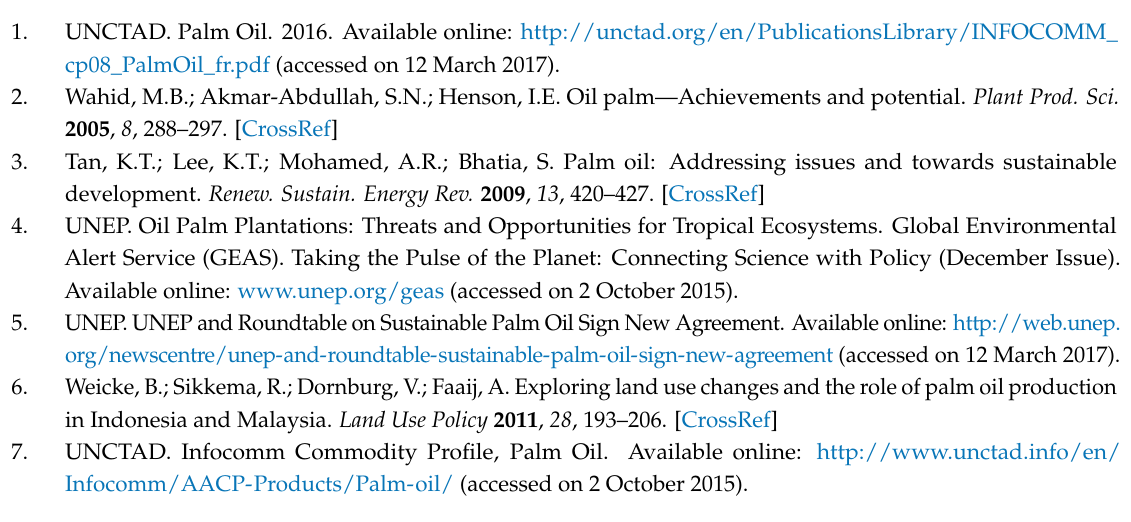
Figure S1: Default values for remaining SOC fraction after land use change from [17] and IPCC (Penman et al., 2003), Table S1: Change of SOC stock on conversion of primary forest land in subtropical and tropical (30 ◦ N–30 ◦ S) regions, Table S2: Change of SOC stock on conversion of secondary forest land in subtropical and tropical (30 ◦ N–30 ◦ S) regions, Table S3: Change of SOC stock on conversion of pasture and grassland in subtropical and tropical (30 ◦ N–30 ◦ S) regions, Table S4: Change of SOC stock on conversion of cropland in subtropical and tropical (30 ◦ N–30 ◦ S) regions, Table S5: Annual N 2 O fluxes in primary forests and in the associated land use change in subtropical and tropical (30 ◦ N–30 ◦ S) regions, Table S6: Annual CH 4 fluxes in primary forests and following land use change in subtropical and tropical (30 ◦ N–30 ◦ S) regions, Table S7: Annual N 2 O fluxes in secondary forests and following land use change in subtropical and tropical (30 ◦ N–30 ◦ S) regions, Table S8: Annual CH 4 fluxes in secondary forests and following land use change in subtropical and tropical (30 ◦ N–30 ◦ S) regions, Table S9: Annual N 2 O fluxes in natural savannah